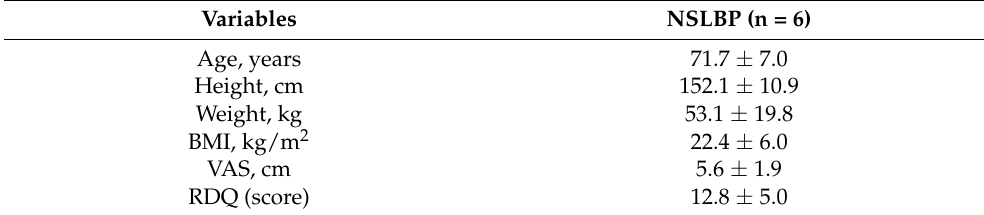
Table 1. Demographic characteristics and functional outcome of the patients.